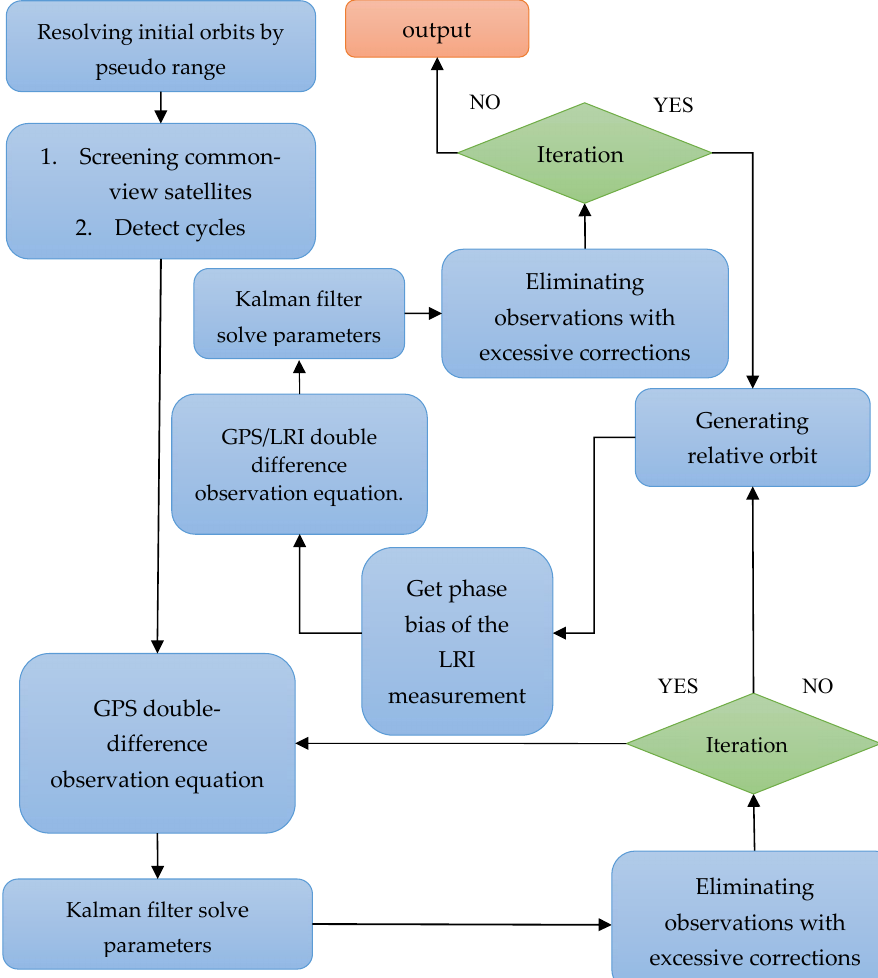
Figure 1. Orbit determination